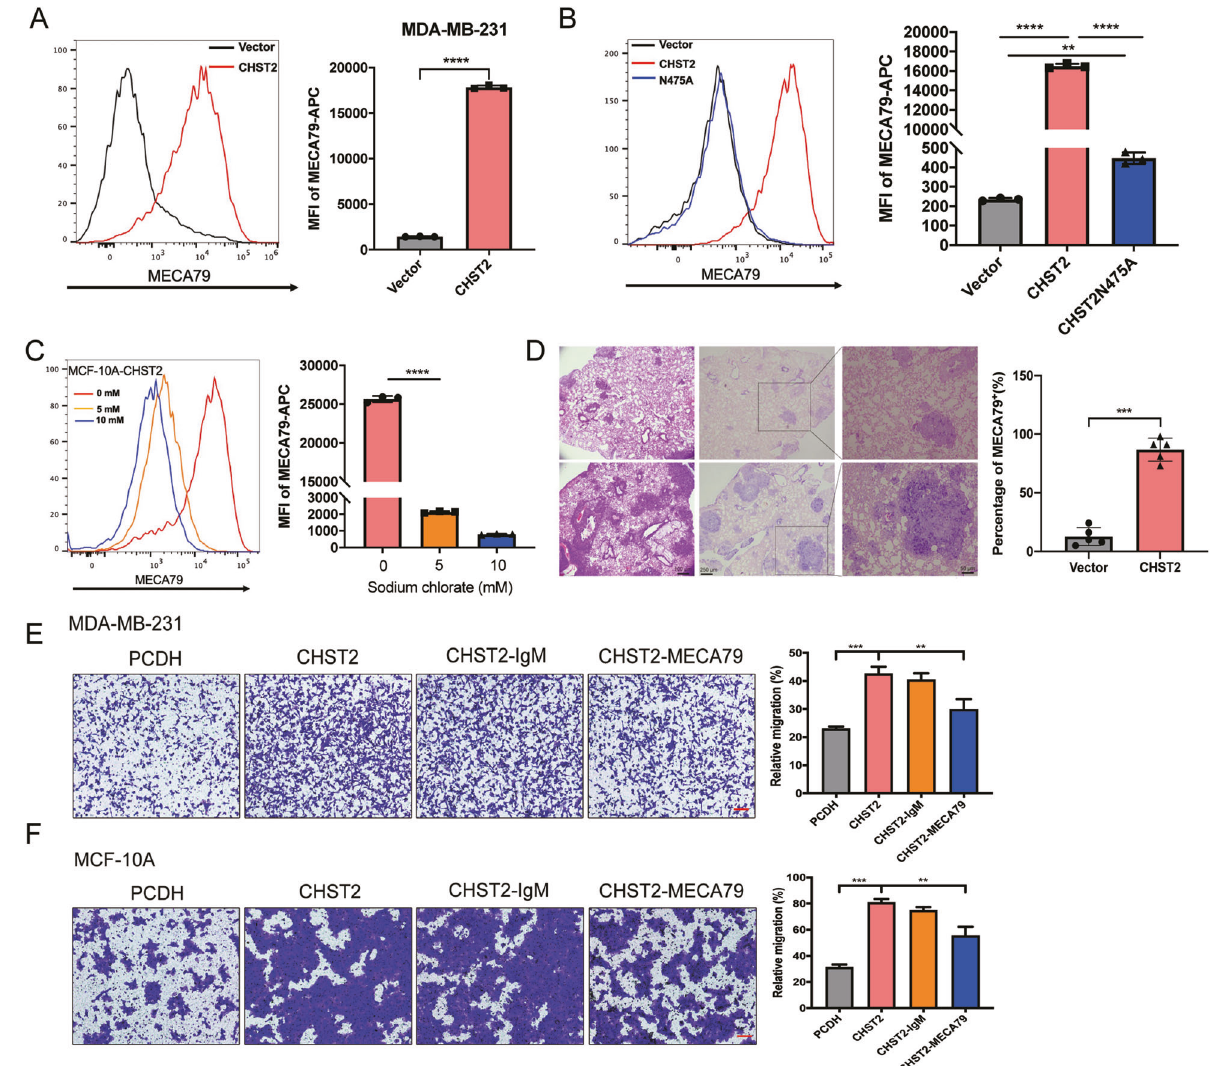
Fig. 4 CHST2 is involved in MECA79 antigen synthesis to mediate breast cancer metastasis. A FACS analysis of MDA-MB-231-Vector (black) and MDA-MB-231-CHST2 (red) cells stained by MECA79 mAb, left panel: Representative histograms were shown. Right panel: MFI of MECA79 antigen synthesis by breast cancer cells was shown compared with vector group, MFI, mean fl uorescence intensity, the MFI of MECA79 less the MFI of isotype control equals the Delta MFI. Data were shown as mean ± SD, **** P < 0.0001, Student t test. B Flow cytometry analysis of the MECA79 surface expression in MCF-10A-Vector (black), CHST2 (red) or mutant CHST2-N475A (blue) cells, left panel: Representative histograms were shown. Right panel: Relative MFI of MECA79 antigen synthesis by MCF-10A cells was shown compared with the vector group. Data were shown as mean ± SD from three independent experiments. **** P < 0.0001, ** P < 0.01, Student t test. C Flow cytometry analysis of the MECA79 surface expression in MCF-10A-CHST2 cells with treatment of 0, 5, 10 mM sodium chlorate for 48 h, left panel: Representative histograms were shown. Right panel: MFI of MECA79 antigen synthesis by MCF-10A-CHST2 cells was shown. Data were shown as mean ± SD from three independent experiments. **** P < 0.0001, Student t test. D H&E staining and Immunohistochemical staining of MECA79 antigen of the lung sections isolated from lung metastatic mice models. E , F Transwell assays in MDA-MB-231-Vector or MCF-10A-Vector and MDA-MB- 231-CHST2 or MCF-10A -CHST2 cells with MECA79 or isotype antibody treated (left panel), Six fi elds chosen randomly were counted for statistical analysis (right panel) and data were shown as mean ± SD, *** P < 0.001, ** P < 0.01. Student t